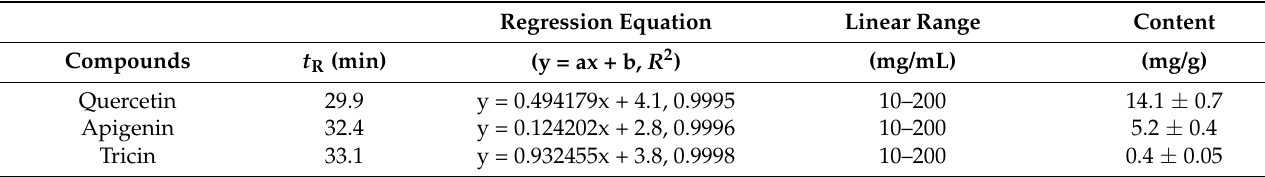
Figure 7. Identification and measurement of the components of EAA by HPLC analysis. HPLC chromatograms of EAA ( a ) and the three standard compound mixtures ( b ) at 280 nm, including quercetin, apigenin, and tricin. Table 1. Quantitative analysis of the constituents in EAA.